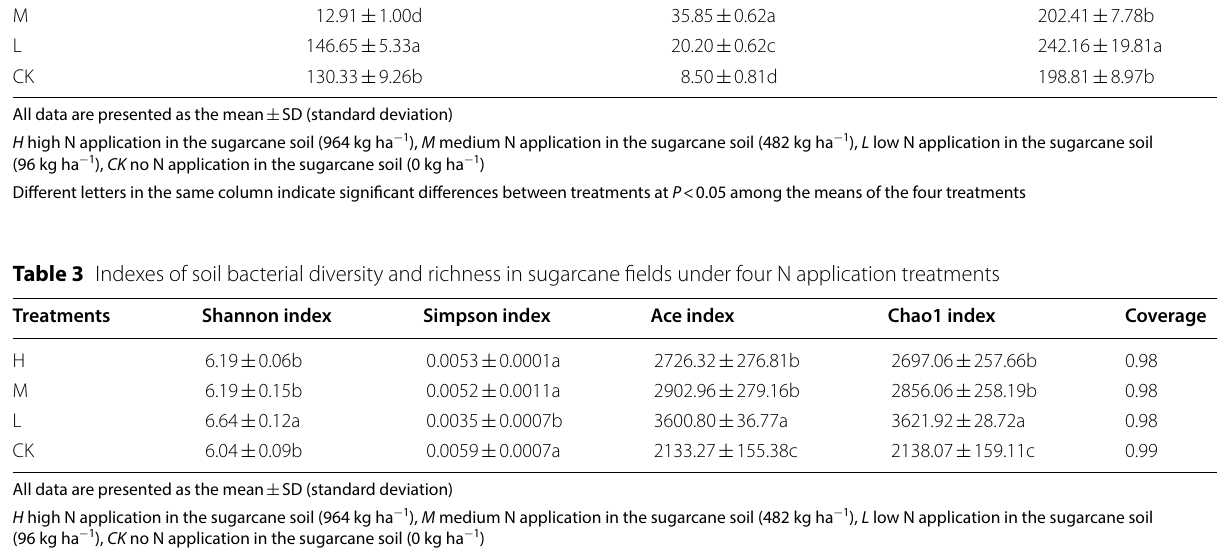
Table 2 Effect of different N applications on soil microbial biomass C, N and P in sugarcane fields (mg kg − 1 ) Treatments